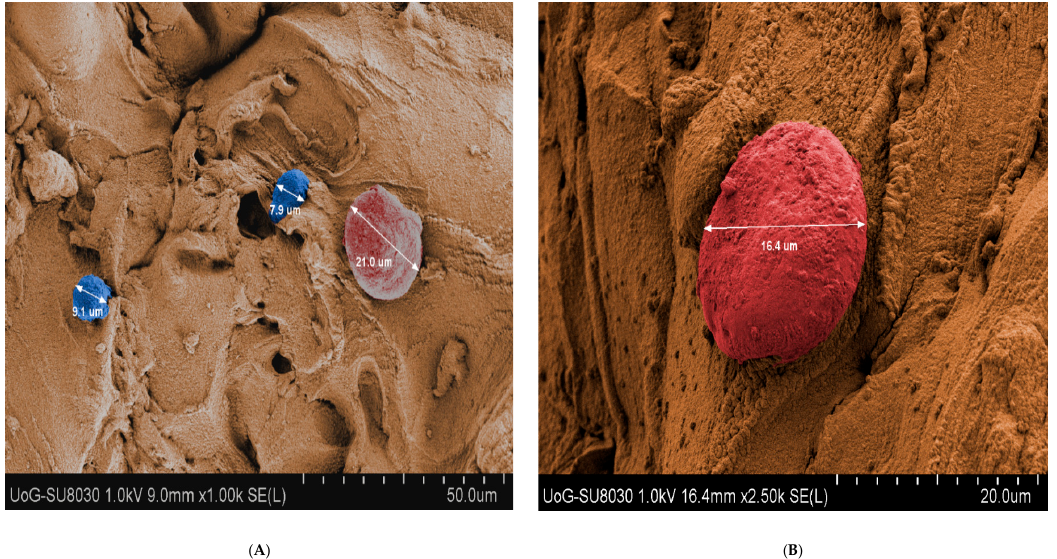
Figure 8. ( A ) SEM image of HDFs (red) and KCs (blue) within 3D bioprinted construct at day 1, ( B ) SEM image of HDFs and KCs within 3D printed construct at day 7 under various magnifications.